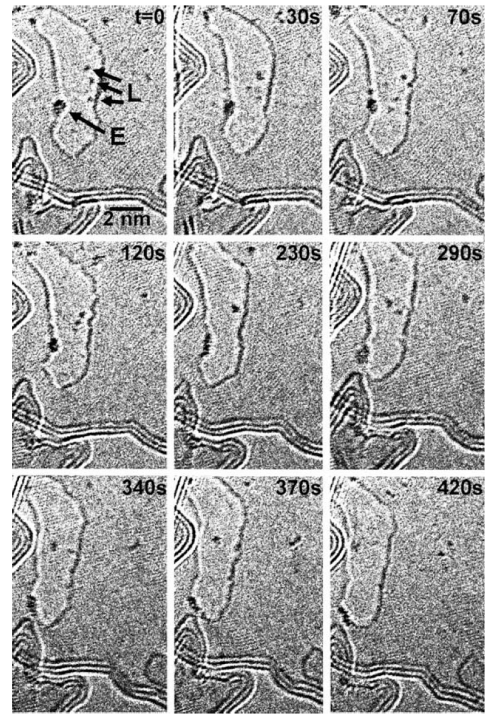
Figure 19. Series of Transmission Electron Microscopies showing the diffusion of Pt atoms in graphene at 600 °C as a function of time. “L” marks the region in a two-three layer graphene where Pt atoms are diffusing in two dimensions. “E” marks a Pt cluster located at the edge of a graphene layer and where Pt atoms are observed one-dimensionally diffuse along the edge. Reproduced from Reference [58] with permission from Wiley.